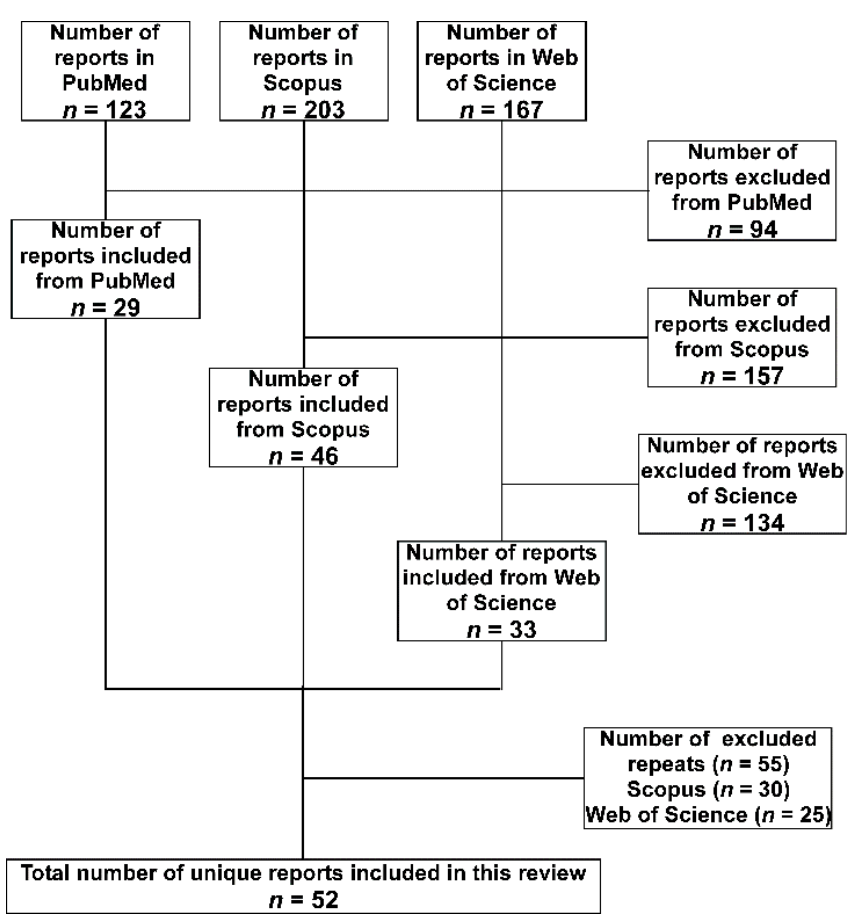
Figure 1. Flow diagram of the search strategy and selection of articles adopted in the current review. The databases were searched in the order (PubMed, Scopus, and Web of Science). Accordingly, articles found in the subsequent database(s) were considered a repeat and excluded.